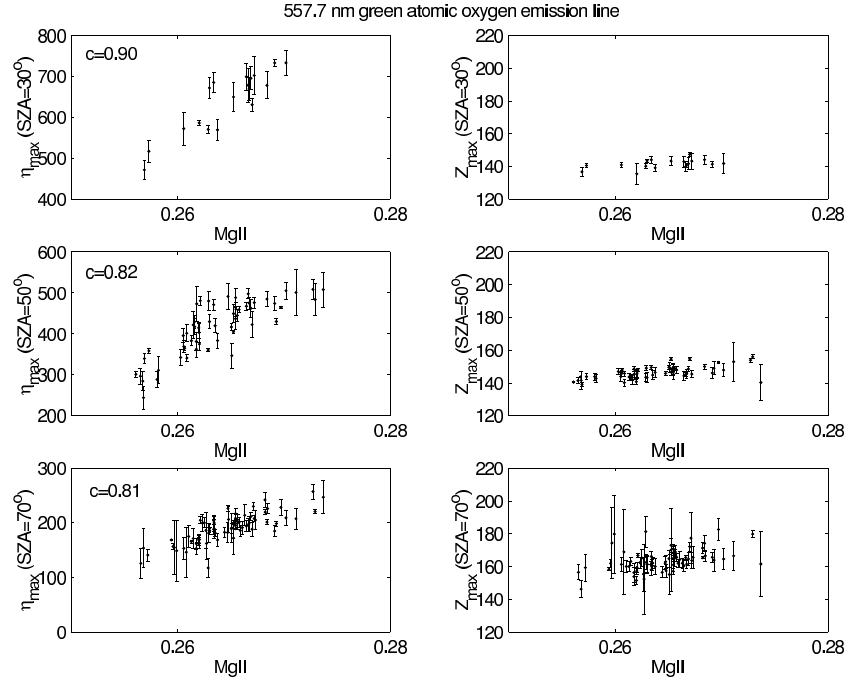
Fig. 14. WINDII measurements of the 557.7nm (thermospheric peak) volume emission rates and maximum emission altitudes for quiet geomagnetic days ( A p ≤ 10), from 1992 to 1995. Data are plotted versus the MgII index, and error bars correspond to the standard